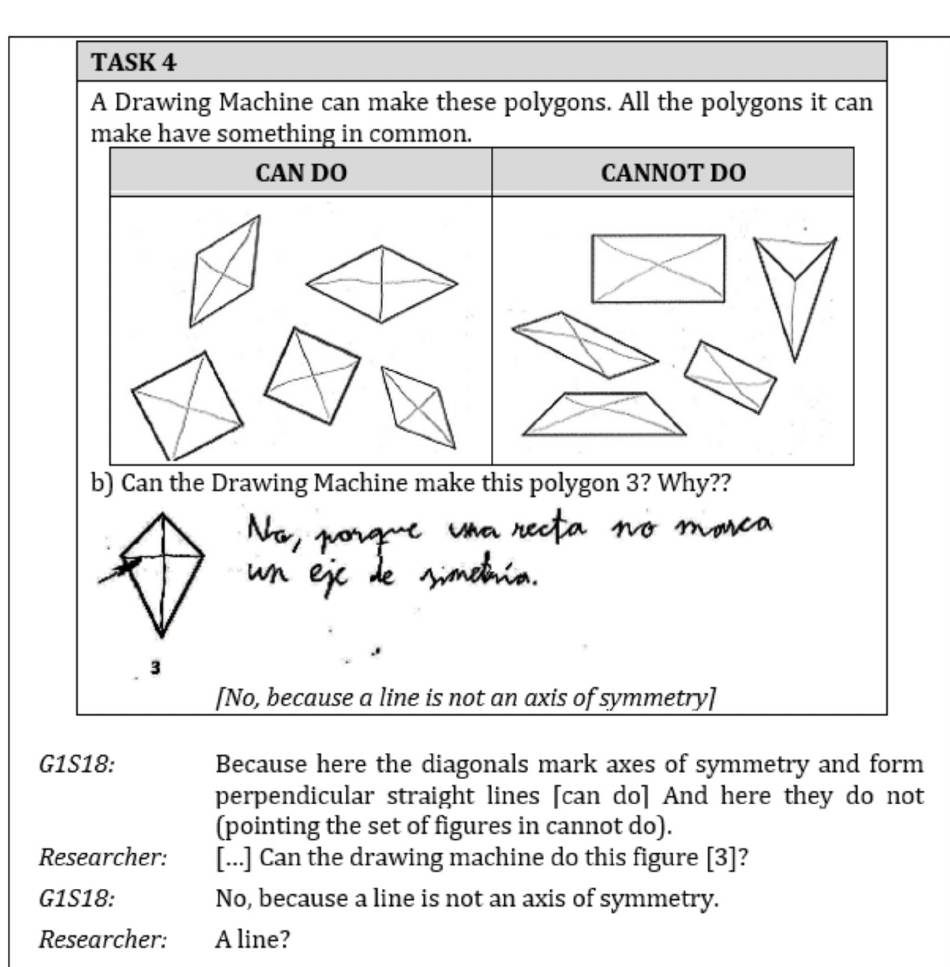
Figure 18. The answer given by student G1S18 in the middle interview when performing the task of identifying the common attribute in a set of polygons (having diagonals marking axes of